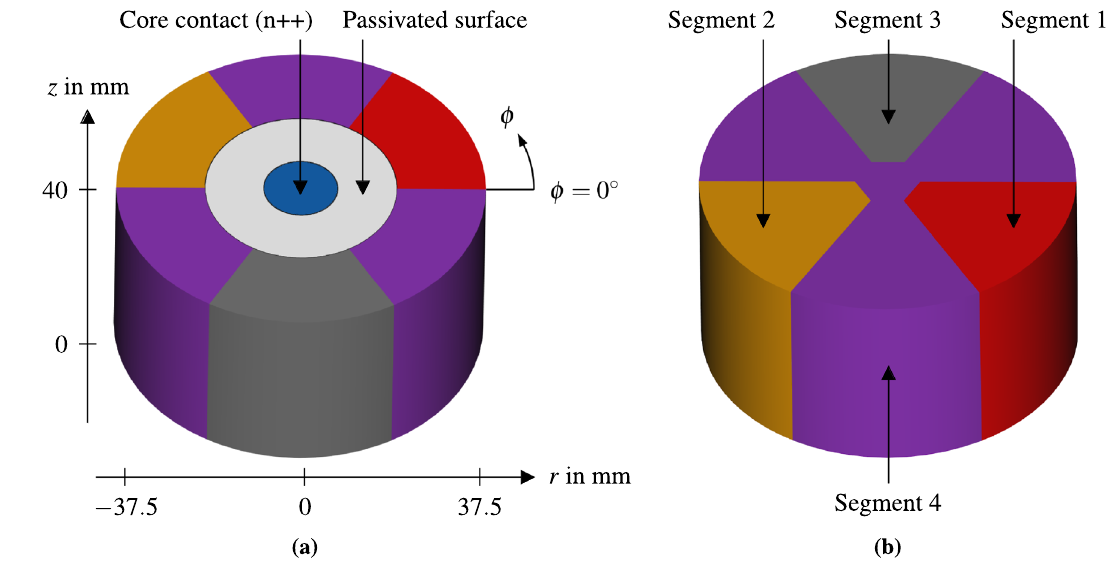
Fig. 4 Schematic of the n-type segBEGe detector [36] used in the first Compton Scanner measurement campaign: a top view and b bottom view. In a , the cylindrical coordinate system to describe positions in the segBEGe detector is